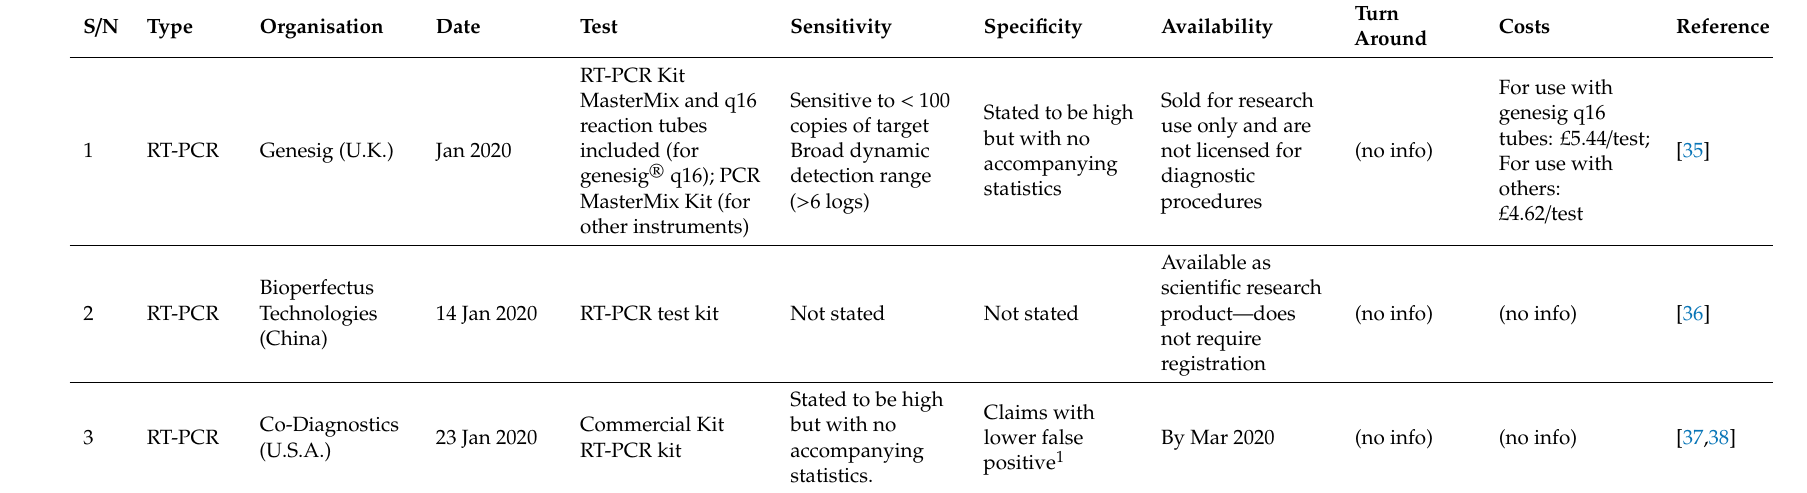
Table 2. Potential commercial rapid diagnostic kits for